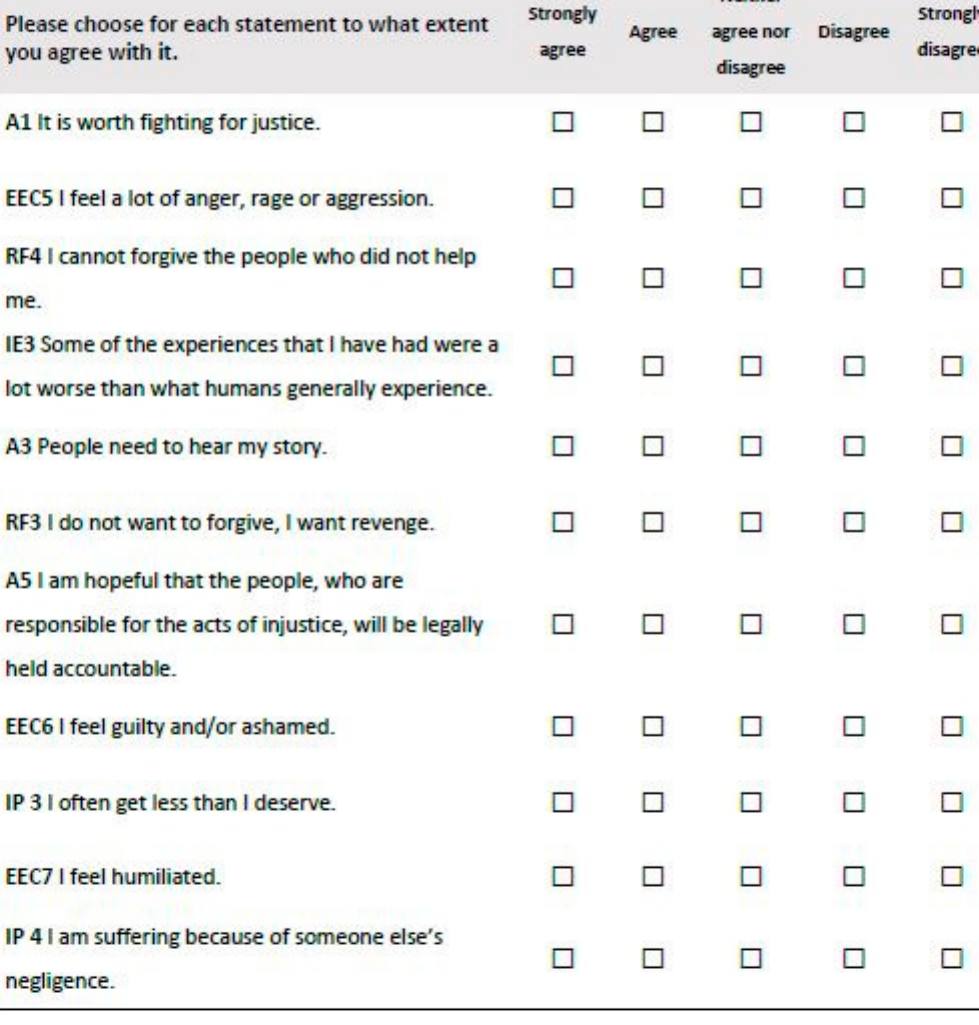
Figure A1. The PIQ, page 1.